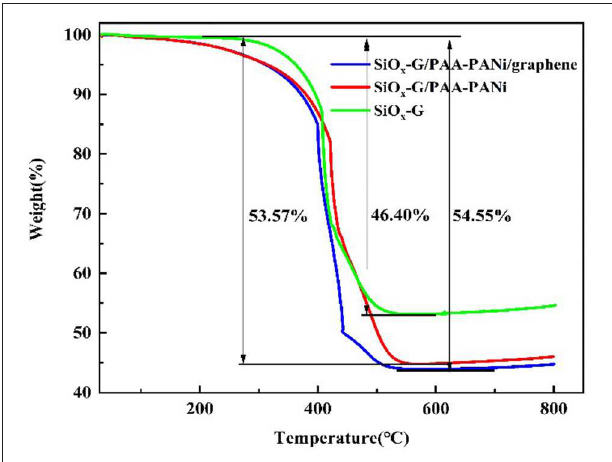
FIGURE 5 | TG image of SiO x -G, SiO x -G/PAA-PANi and SiO x -G/PAA-PANi/graphene.